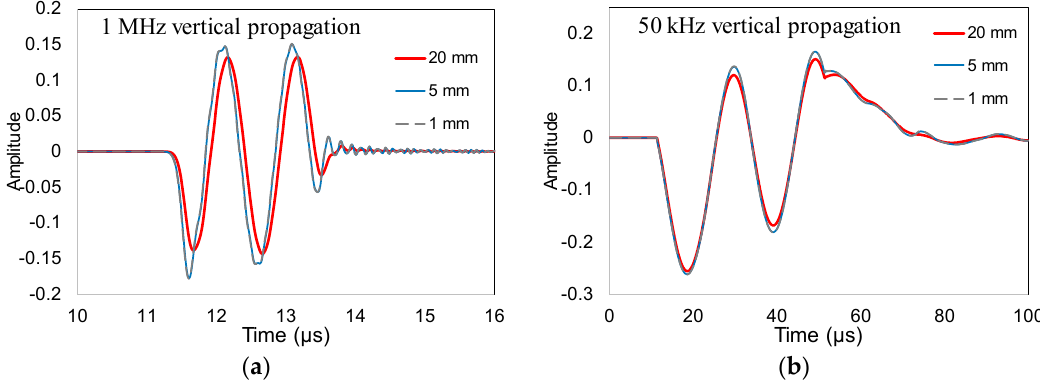
Figure 5. ( a ) Waveforms received by different size sensors for the case of vertical source and excitation frequency of 1 MHz; ( b ) Waveforms received by different size sensors for the case of vertical source and excitation frequency of 50 kHz.